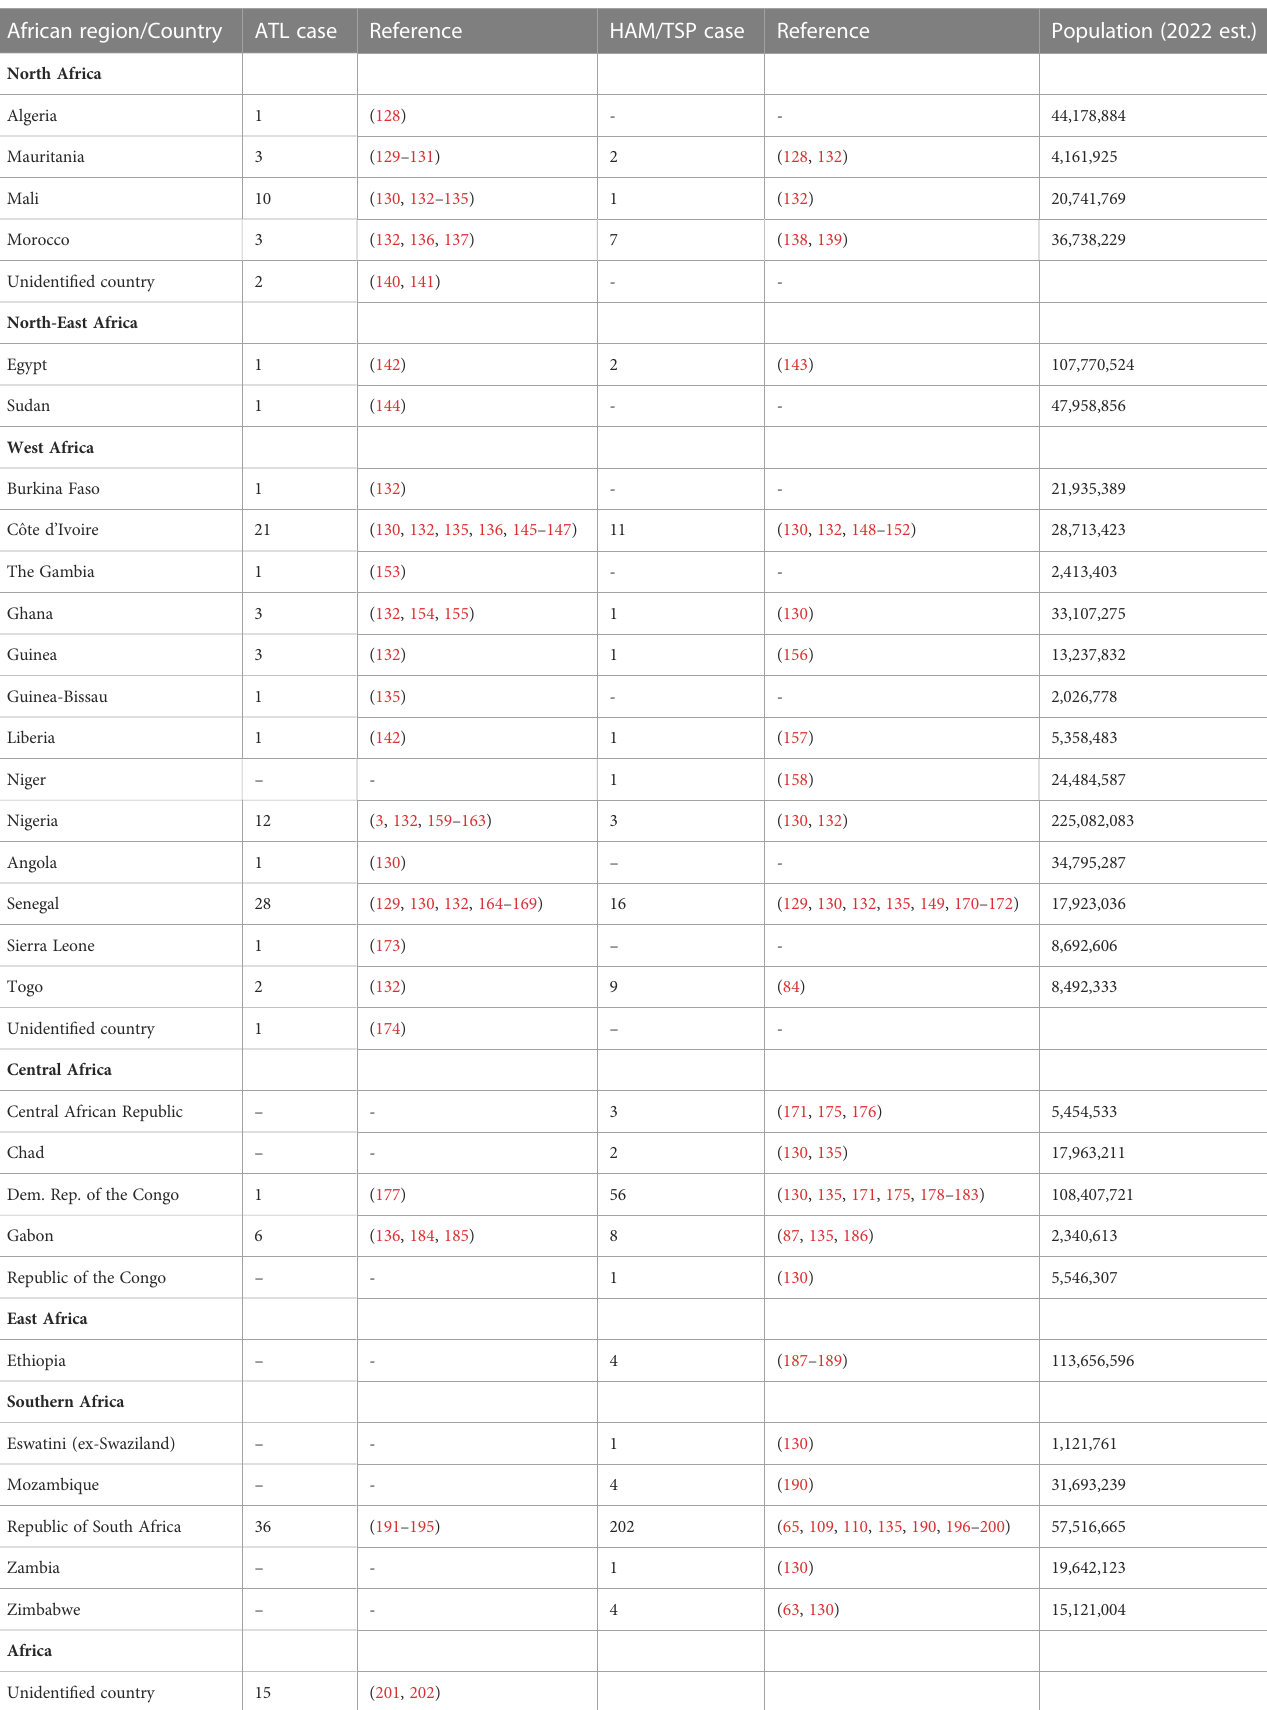
TABLE 5 HAM/TSP and ATL cases reported in 33 African countries and Indian Ocean Islands. African region/Country ATL